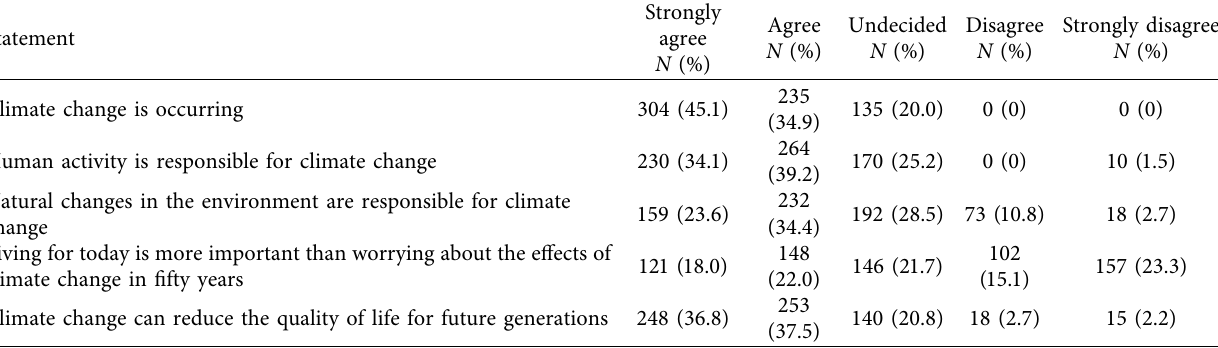
Table 6: Respondents’ attitude towards climate change.